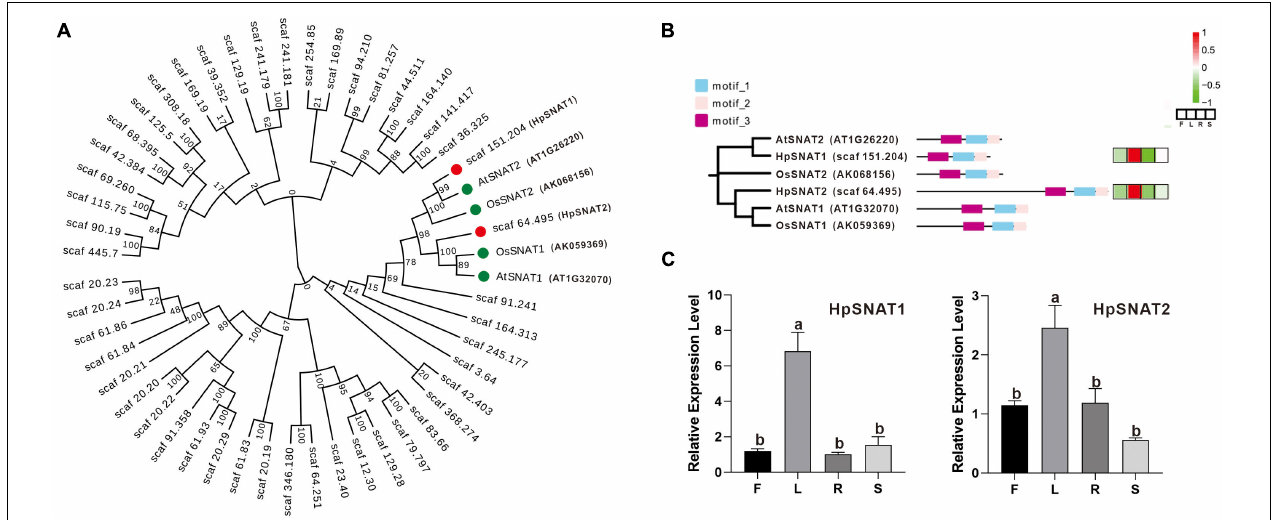
FIGURE 1 | Bioinformatics analysis of HpSNAT. (A) The phylogenetic tree of HpSNAT and the reference proteins AtSNAT1, AtSNAT2, OsSNAT1, and OsSNAT2 from Arabidopsis thaliana and Oryza sativa . The sequences were analyzed by MEGA 10.0 using bootstrap analysis with 1000 replicates. (B) The distribution of three conserved motifs and heat maps of six SNAT proteins. The heatmaps were analyzed by the FPKM values (F: flowers, L: leaves, R: roots, and S: stems) for each protein ( Z -score). (C) Relative quantitative analysis of HpSNAT1 and HpSNAT2 in different tissues of Hypericum perforatum . Data were normalized by HpACT2 (MK054303), calculated with the equation 2 −(cid:52)(cid:52) Ct . All data represent averages of three biological replicates, error bars indicate ± SD. Different letters indicate significant differences from the control ( P < 0.05) tested by one-way